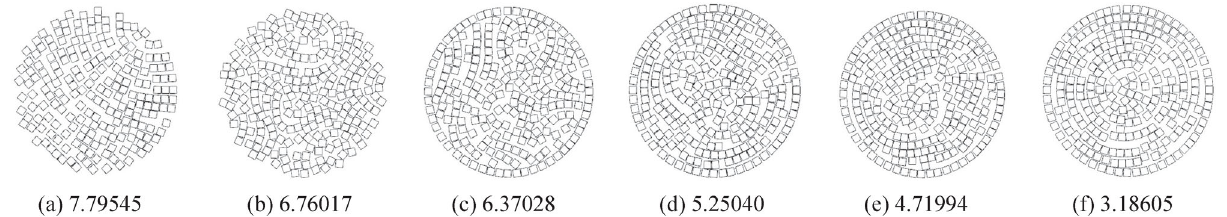
Fig. 5 Different patch sets and their